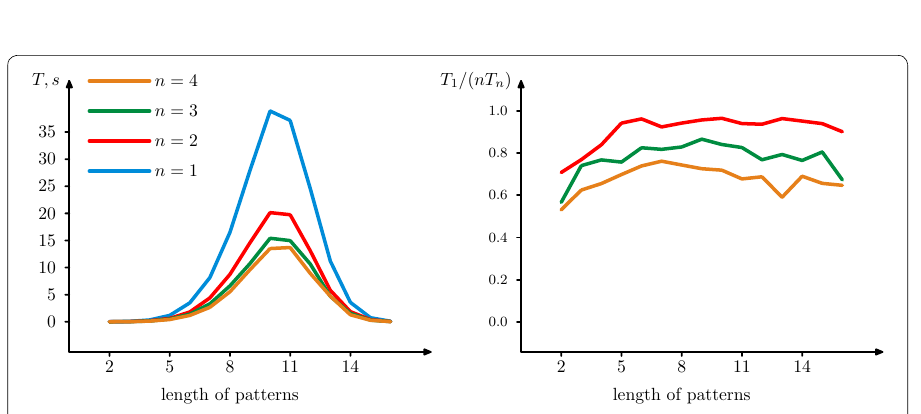
Fig. 11 Run time for the expensive care dataset for different number of